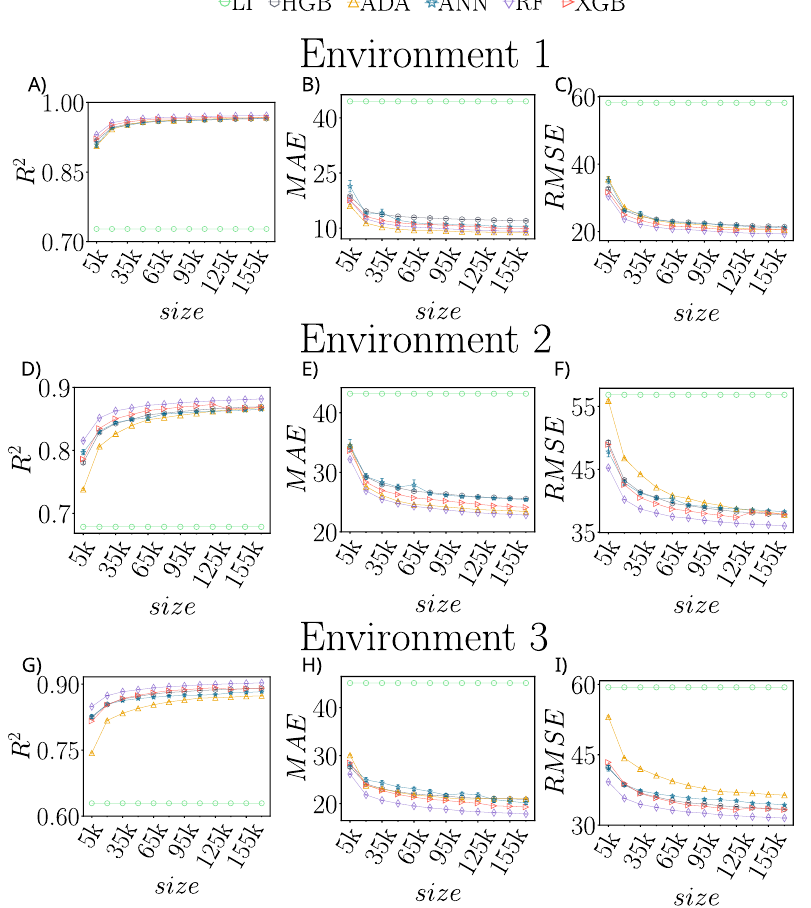
Figure 5. For each environment, three Figures are illustrated, each with a different metric ( Y axis) related to the amount of data used in the model training phase ( X axis). These metrics are R 2 , MAE and RMSE. R 2 corresponds to ( A , D , G ). MAE corresponds to ( B , E , H ). Lastly the RMSE corresponds to ( C , F , I ). The green circles, gray hexagons, yellow triangles, blue stars, purple diamonds, and orange rotated triangles correspond to the predictions of LI, Histogram-Based Gradient Boost, Ada Boost, ANN, Random Forest e XGBoost, respectively. The bars, on the other hand, refers to the standard deviation, being related to each model through color. The values shown in the illustration are the result of averaging the X , Y , and Z axis predictions in the